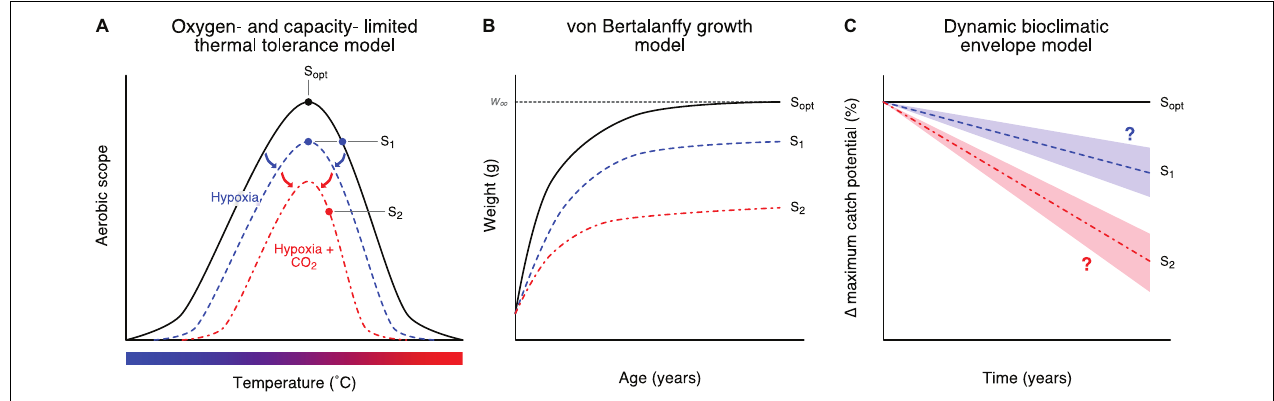
FIGURE 1 | Modelling the pathway of the impacts of ocean acidification from organism to population level in a multi-stressor framework. OA impacts were modelled as (A) physiological impacts (Pörtner and Lannig, 2009), then translated to (B) impacts on growth (Cheung et al., 2011), and (C) impacts on fisheries catch potential (Cheung et al., 2016c). S opt is the optimal temperature at which aerobic scope is at maximum. Deviations in temperature or other stressors such as hypoxia shrink the overall performance curve (blue curve) and reduce the overall aerobic scope (S 1 ) (A) , leading to reductions in growth rate and maximum attainable size (w ∞ ) (B) , as well as potential decreases in fisheries catch (C) . Multi-stressor impacts of temperature, hypoxia, and elevated acidity will exacerbate physiological limitations and impacts on fisheries catch (red curve; S 2